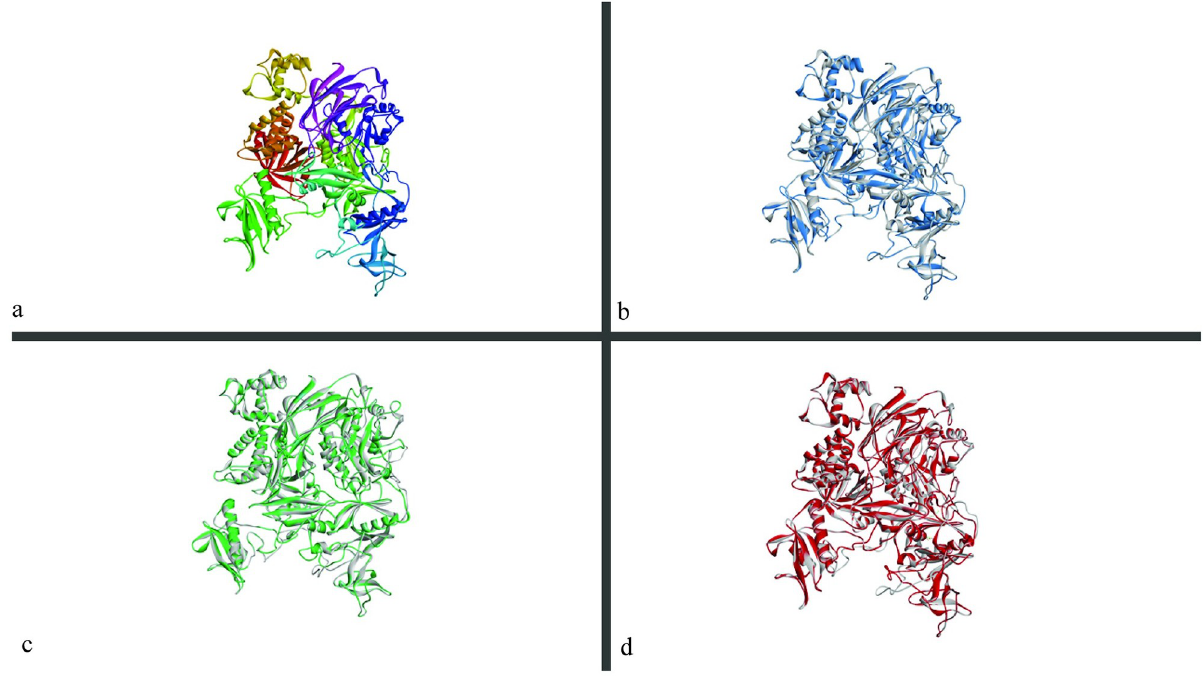
Fig 3. (a) Native wild type structure made by SWISS-MODEL. (b) Superimposed image of native protein structure onto mutant L455F (blue) protein structure, (c) mutant L411P (green) protein structure, (d) mutant G493D (red) protein structure. (Visualized by BIOVIA discovery studio visualizer). https://doi.org/10.1371/journal.pone.0260054.g003 value showing differences in the structures and the hydrogen bonds compared to the wild structures. L411P and L455F showed mutation cluster in the prediction by Mutation 3D (Table 7). Three SNPs showed changes in hydrophobicity and number of hydrogen bonds, after further analysis by BIOVIA discovery studio visualizer (Table 8). The mutant protein structures of the three SNPs are given (Fig 3b–3d). The intermolecular bonds generated by the wild type and mutant structures of the three SNPs-G493D, L411P and L455F, are shown respectively (Figs 4–6). Finally, the comparative superimposed structures showing hydrogen bonds and their difference in numbers and angles are shown (Fig 7). Analysis of 5’ and 3’ UTR non-coding SNPs After setting the MAF filter of � 0.001, 65 SNPs were found in the Ensemble database. In Reg- ulome DB only the SNPs with ranking < 4 were taken into consideration, and nine SNPs were chosen. The rankings along with probability score and Chip data are given (Table 9). Table 8. Chemical analysis result of target SNPs by BIOVIA discovery studio visualizer. SNP Amino acid